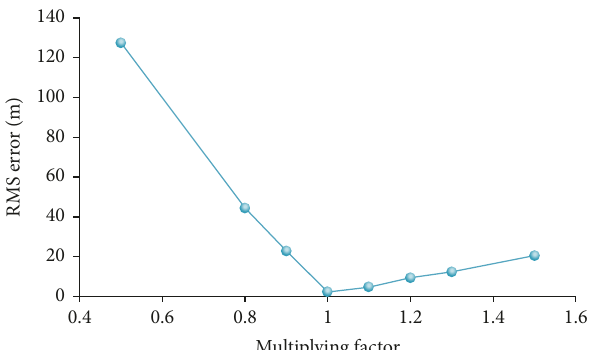
Figure 8: Sensitivity analysis with respect to recharge.